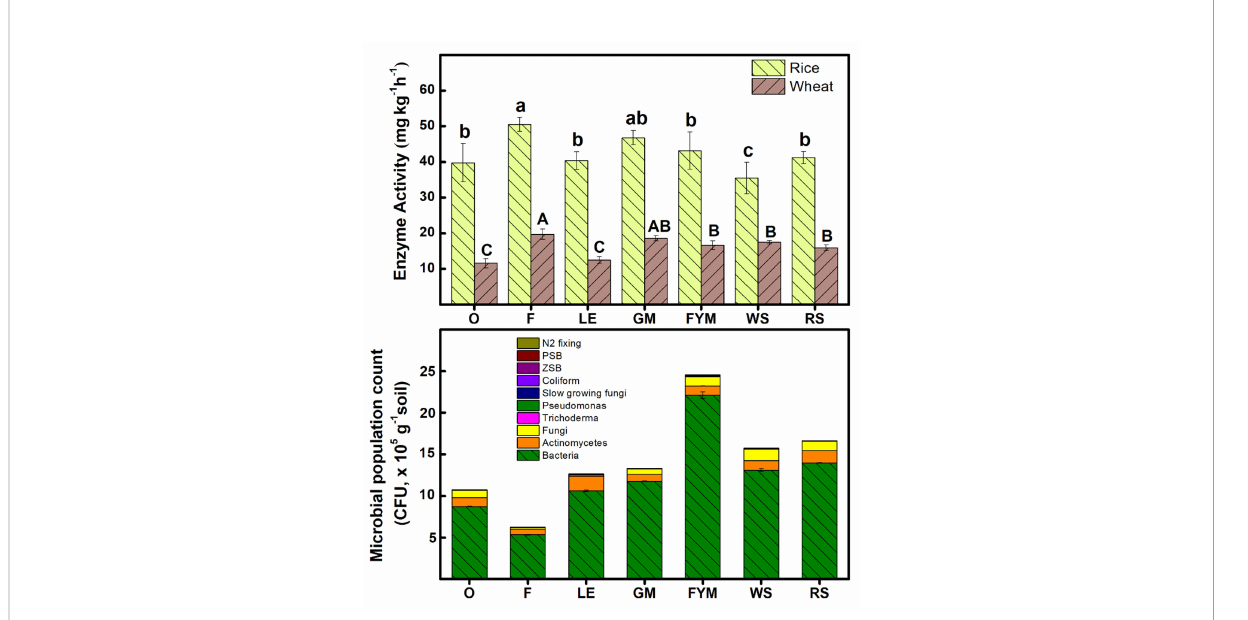
FIGURE 8 Effect of different nutrient management practices on the aggregated soil enzymatic activity, and soil microbial population. Error bars denote ± 1SD. Different letters indicate signi fi cant differences (P ≤ 0.05). Refer to Figure 2 for the description of treatments.